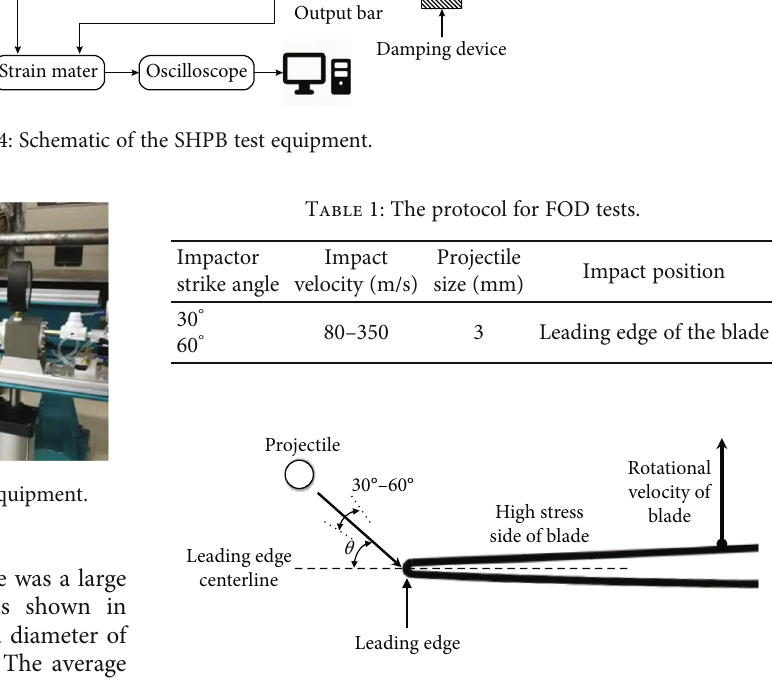
Figure 6: Schematic showing the orientations of the impacting